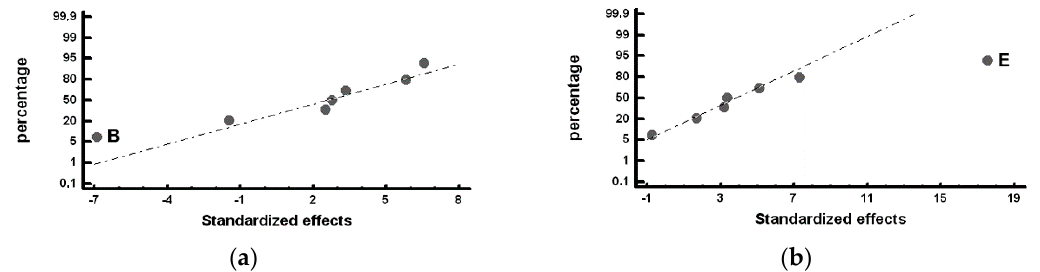
Figure 6. Standardized effects on the percentage of graphite with a nodular morphology, on a normal probability plot: ( a ) Factors with a significant effect on the outermost region of the working layer (Zone α ); ( b ) Factors with a significant effect on the inner region of the working layer (Zone β ).